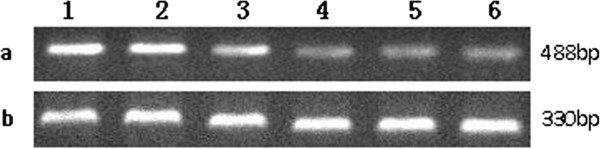
The expression of COX-2 mRNA (12 hours after transfection) a. COX-2 mRNA (488 bp) (1. The control group, 2. Lipofectin group, 3. C1 group: 100 nmol/L, 4. C2 group: 200 nmol/L, 5. C3 group: 400 nmol/L, 6. C4 group: 800 nmol/L); b. GAPDH as an internal control (330 bp).